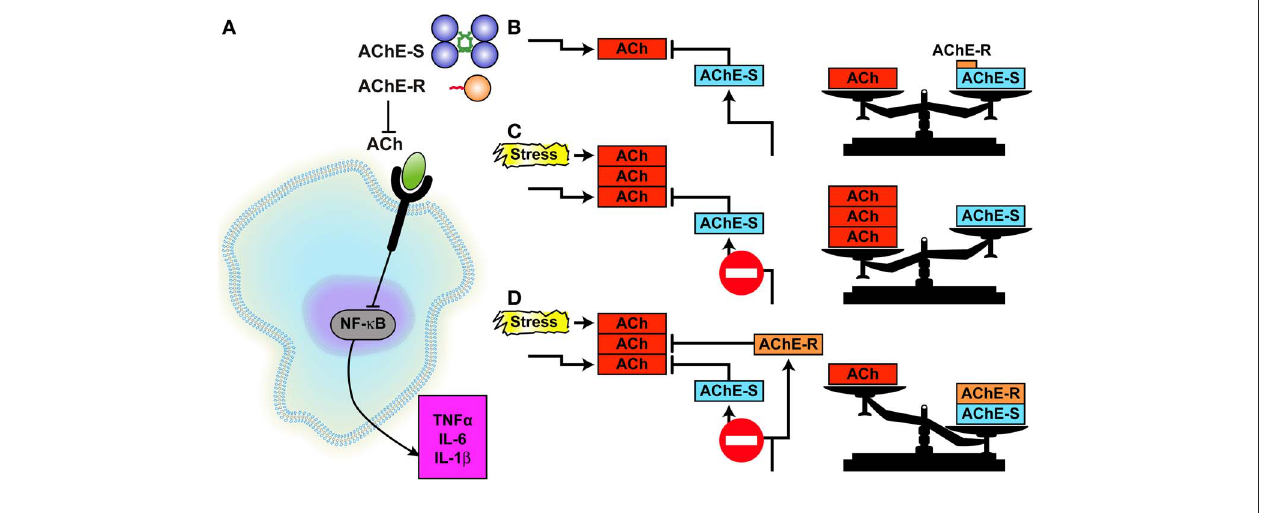
FIGURE 2 | AChE controls the anti-inflammatory reflex. (A) At the extracellular space, both AChE-S and AChE-R hydrolyze ACh, impairing its capacity to block, through the α 7 nicotinic ACh receptor, the activation of NF κ B which enables pro-inflammatory cytokine secretion (the so-called “anti-inflammatory reflex”). (B) Under normal conditions, AChE-S is by